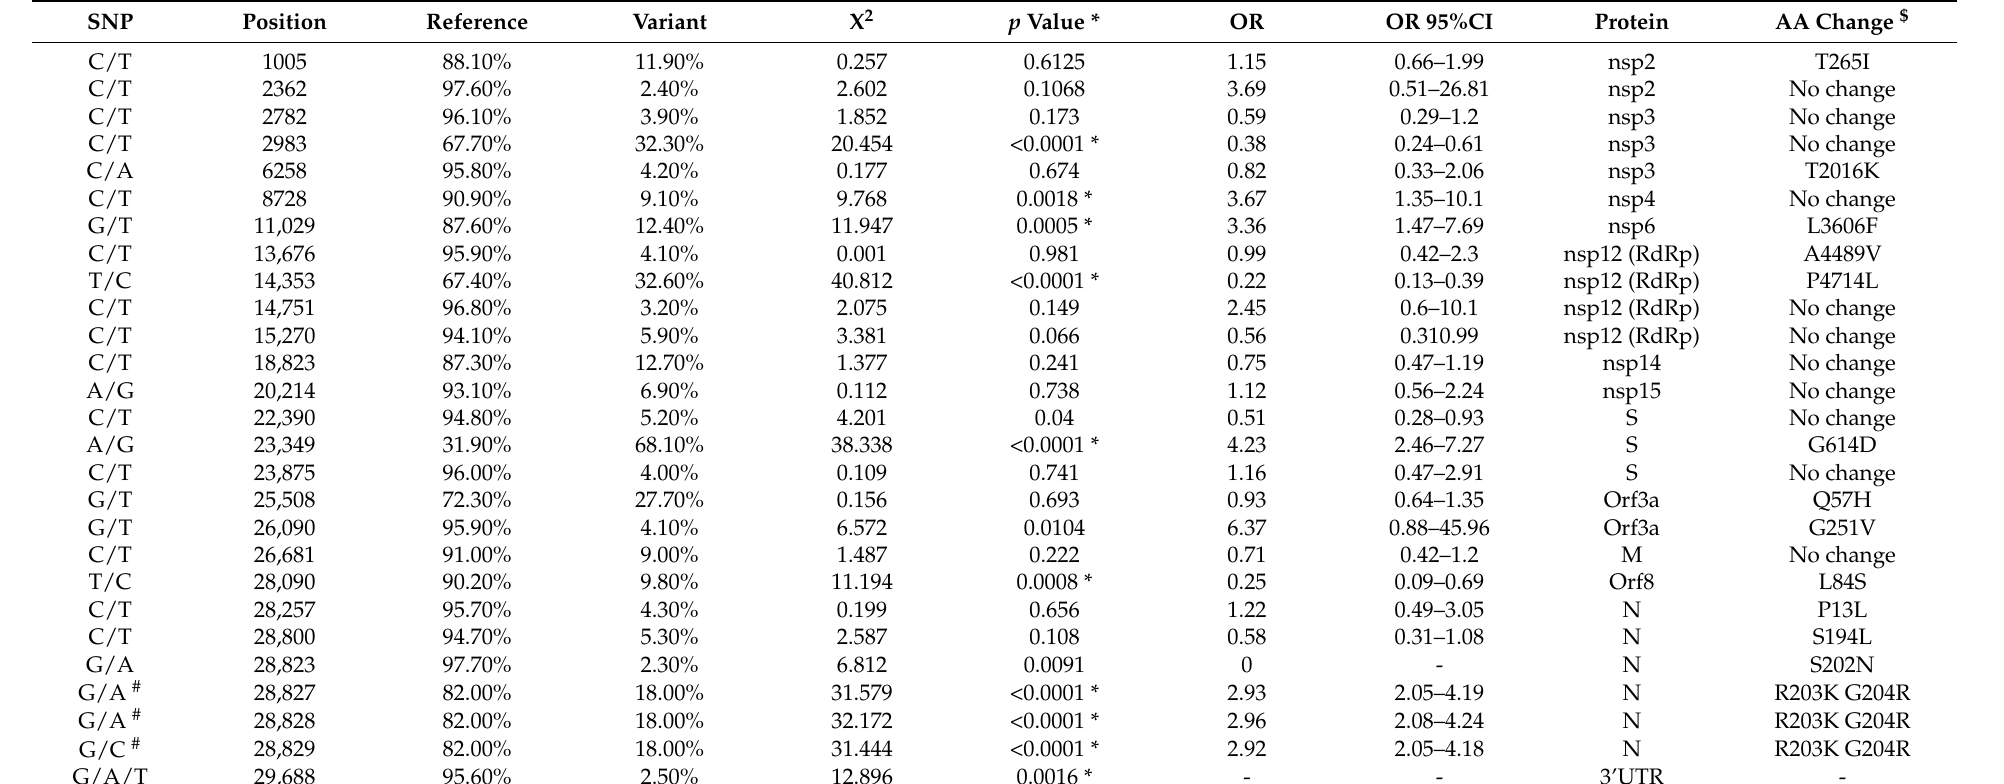
Table 1. SNPs of SARS-CoV-2 and their association with patient